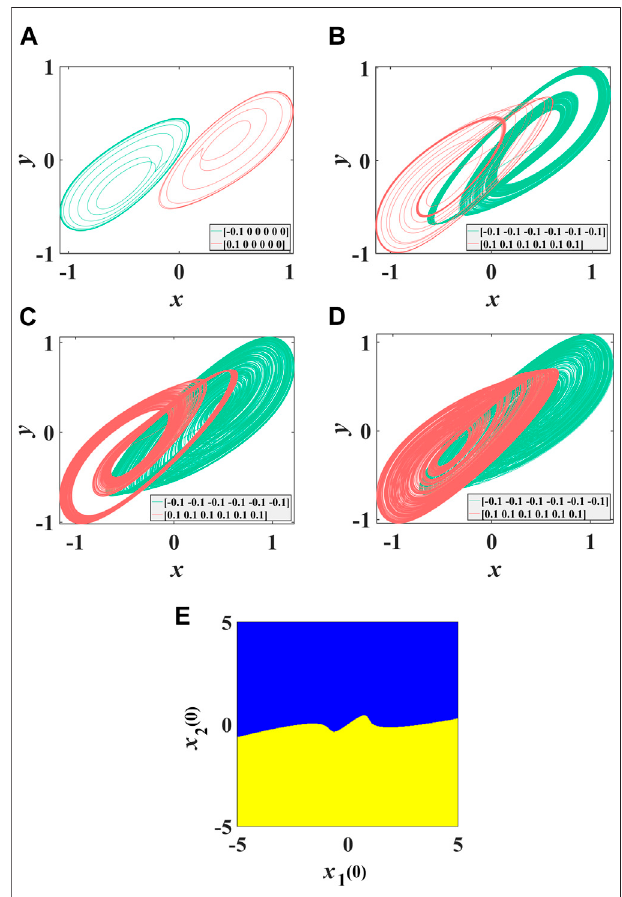
FIGURE 6 | Coexisting attractors and attraction basin. (A) Coexistence of two cycles with k = − 0.05; (B) coexistence of cycle and chaos with k = 0.015; (C) coexistence of two chaos with k = 0.02; (D) coexistence of two chaos with k = 0.025; (E) the attraction basin corresponding to initial state [×1 (0); ×2 (0); 0; 0; 0;